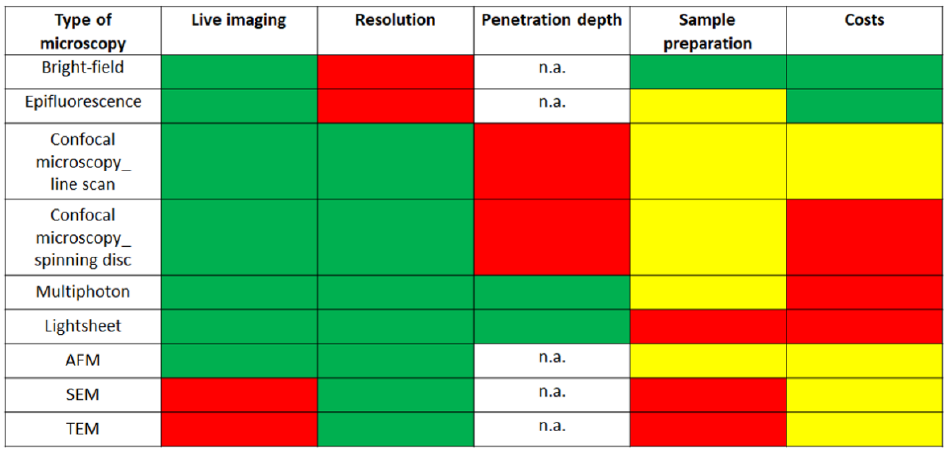
Figure 5. Evaluation of the imaging techniques based on their use in live imaging, resolution, penetration depth, sample preparation and costs. Green color indicates a high, yellow an intermediate and red a low score. n.a., not applicable.